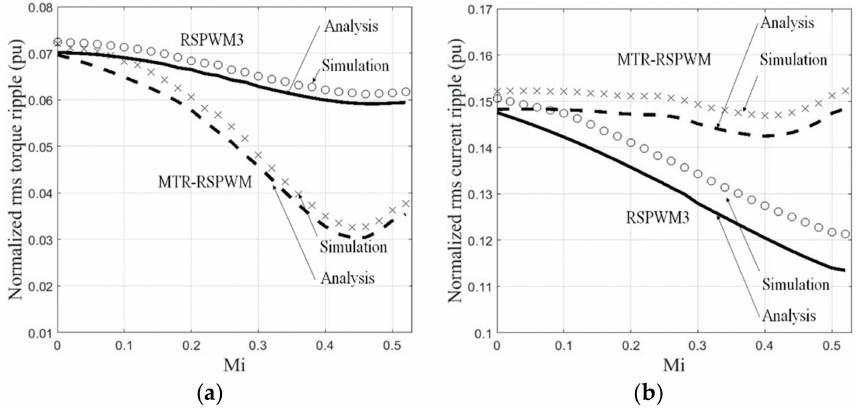
Figure 9. Analytical and simulation results: ( a ) normalized RMS torque ripple; ( b ) normalized RMS current